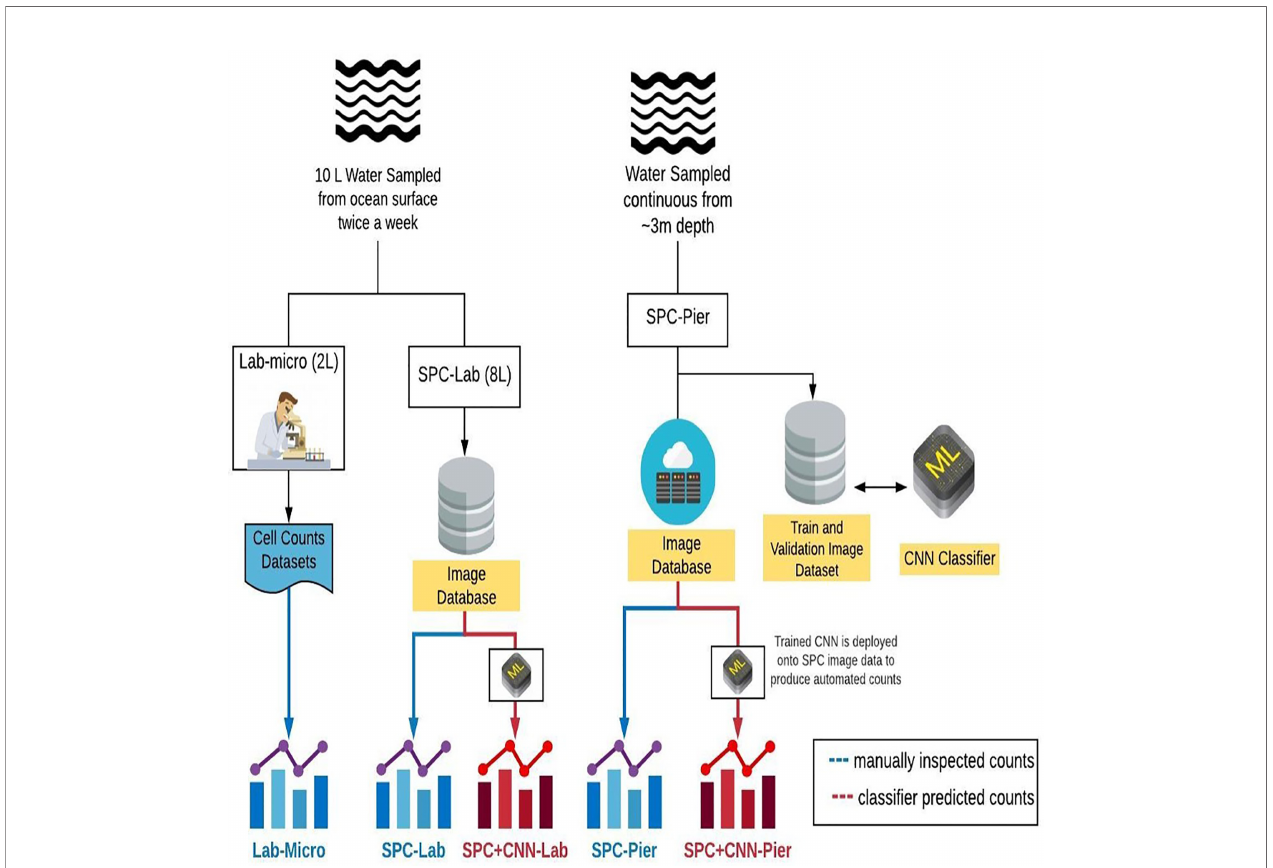
FIGURE 3 | A diagram that compares the sampling methods and the 5 resultant data sets: Lab-micro, SPC-Lab, SPC+CNN-Lab, SPC-Pier and